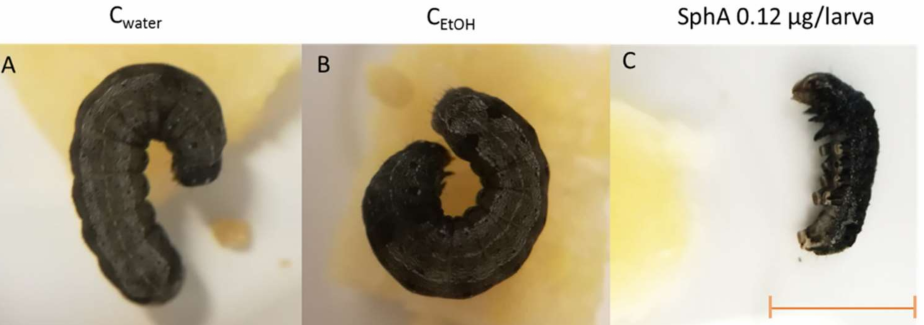
Figure 4. Alteration of S. littoralis larval development following oral administration of SphA. Larvae treated with SphA for three days showed a clear reduction of vitality and body size ( C ) No difference in the larval head capsule size indicates that all the larvae are in the same instar. compared to control larvae treated with water ( A ) or EtOH 50% ( B ). Scale bar, 0.5 cm. Taken together our results indicate that although SphA has no lethal contact activity against S. littoralis larvae it showed clear lethal and sublethal effects after ingestion in 5th instar larvae, unequivocally indicating the oral direct toxicity of SphA. Further investi- gations are needed to better define the insecticidal role of SphA against chewing insects.